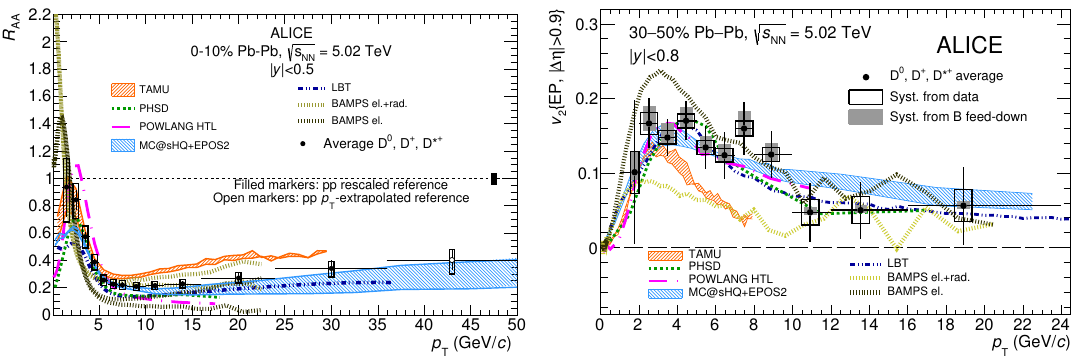
Figure 10 . Average R AA of D 0 , D + and D (cid:3) + mesons in the 0{10% centrality class (left) and their average elliptic (cid:13)ow v 2 in the 30{50% centrality class (right) [66], compared with models that have predictions for both observables at low p T